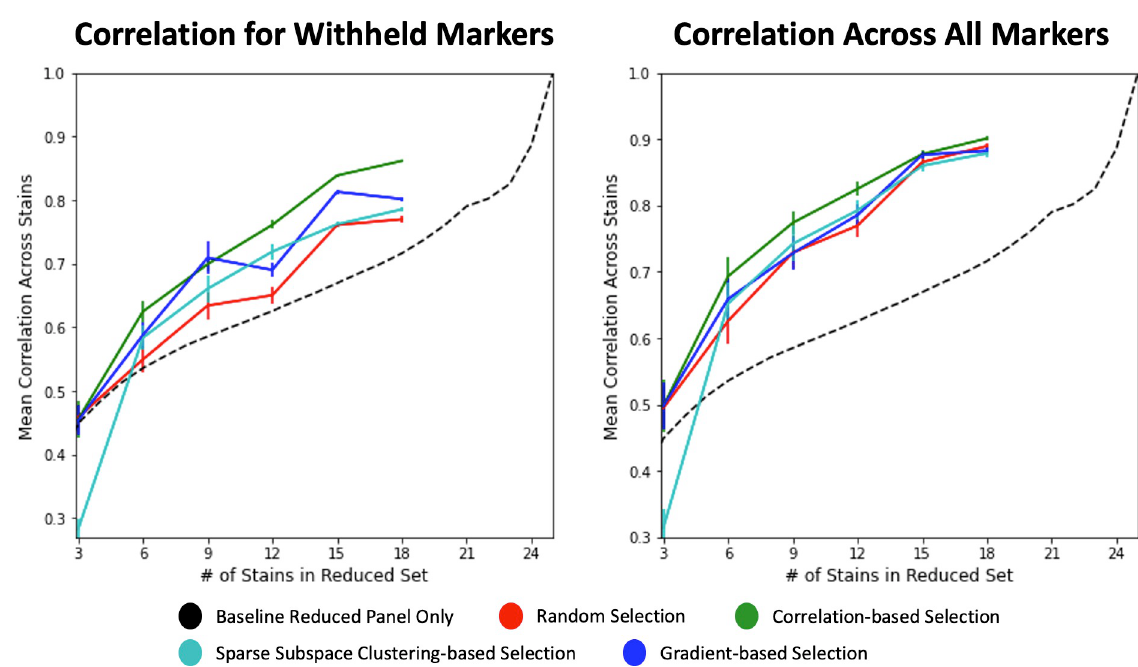
Fig 3. All panel selection methods were evaluated across a range of panel sizes to determine how well their reduced panels can be used to reconstruct the full panel. Spearman correlation was measured for each stain independently and then averaged across the whole dataset. Variance in mean correlation accuracy was also calculated across markers for each panel size and method (n = 25). The data was split into withheld markers (left) and all markers (right) to illustrate each model’s generalizability and performance in both domains. 1-to-1 substitutions of marker intensity were used as the baseline, where makers withheld from the reduced panel set were simply assigned the intensity of their closest match as described in the Methods section.